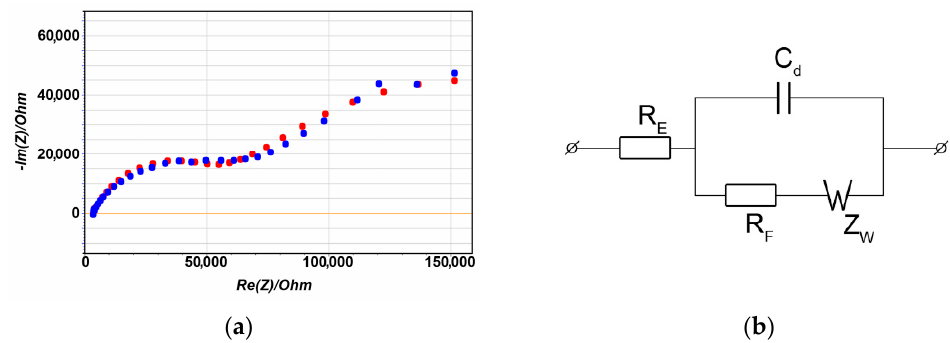
Figure 7. Impedance hodograph ( a ) and equivalent circuit ( b ) of the system “copper needle in a solution of copper sulphate with a concentration of 0.01 mol/dm 3 . The auxiliary electrode is a massive copper plate. The specific Faraday resistance is ( R F ) sp = 0.75 Ohm cm 2 . The specific capacitance of the double layer is ( C d ) sp = 2 ∙ 10 − 5 F/cm 2 . The electrolyte resistance is R E = 4000 Ohm. The specific Warburg constant is W F = 25 Ohm cm 2 s − 0.5 .